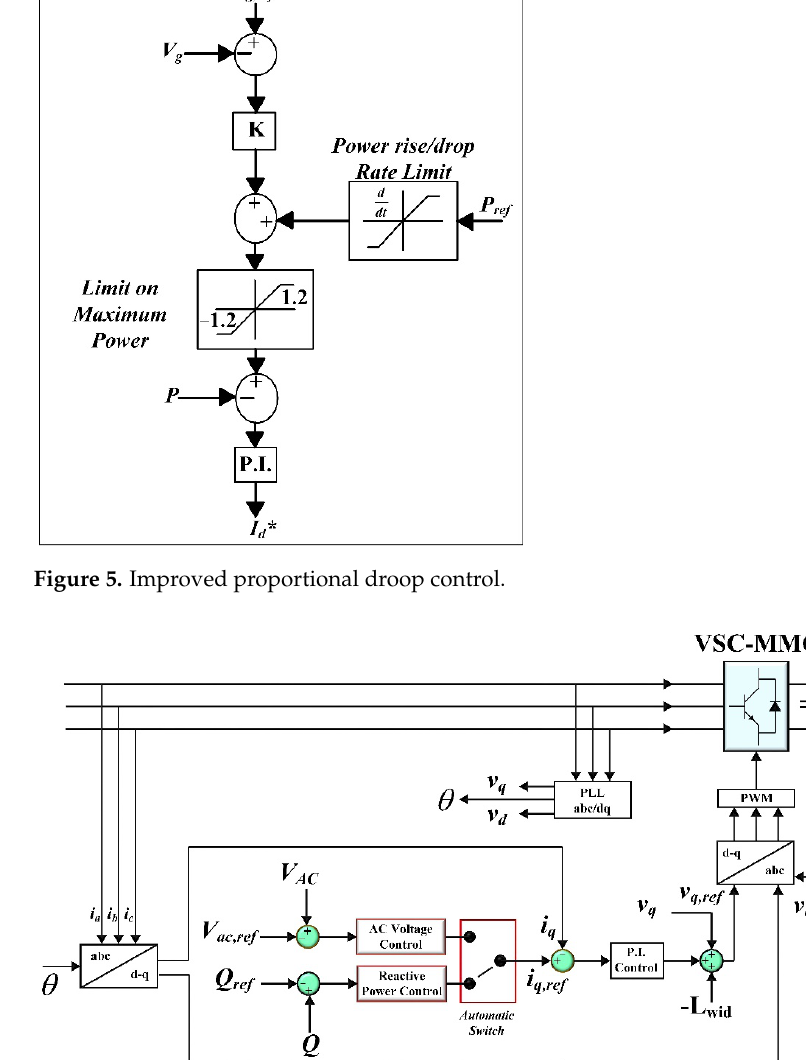
Figure 4. AC voltage controller schematic for wind farms .